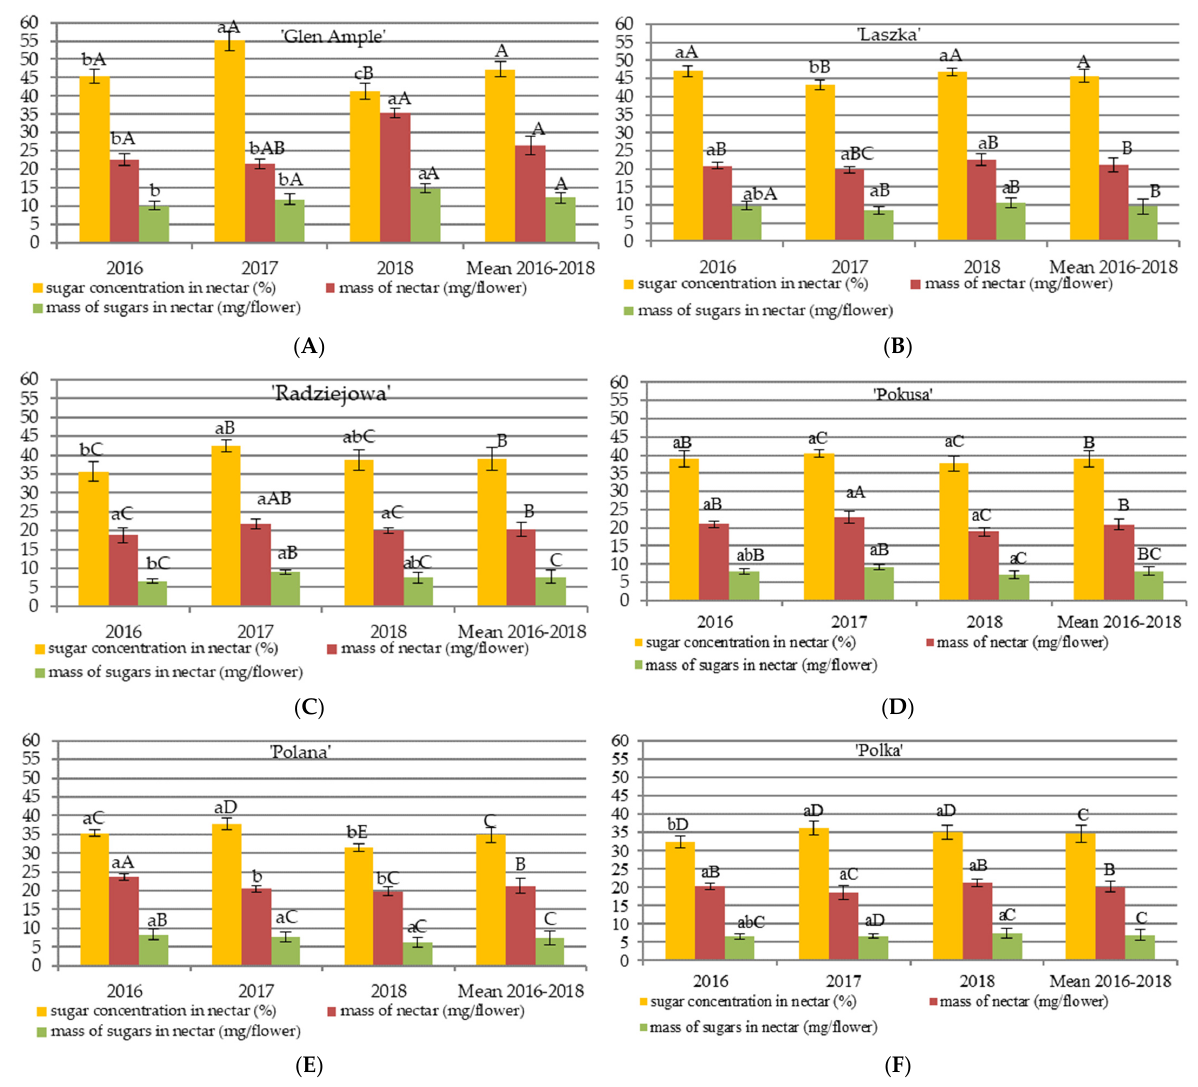
Figure 1. ( A – F ). Nectar abundance: nectar weight, nectar sugar percentage concentration, and nectar sugar weight of the six R. idaeus cultivars analyzed in the three study years. Explanations: means followed by the same small letter are not significantly different within the cultivar in the years, and means followed by the same capital letter do not differ between the cultivars in each year of the study at a significance level α = 0.05 (two-way ANOVA, Tukey’s test). The statistically confirmed differences between the cultivars in the years of the study revealed different trends in the changes in the nectar abundance parameters of the analyzed raspberry cultivars. In terms of the percentage nectar sugar concentration, the taxa were ranked as follows: in 2016—‘Glen Ample’ = ‘Laszka’ > ‘Pokusa’ > ‘Radziejowa’ = ‘Polana’ > ‘Polka’, in 2017—‘Glen Ample’ > ‘Radziejowa’ = ‘Laszka’ > ‘Pokusa’ > ‘Polana’ = ‘Polka’, and in 2018—‘Laszka’ > ‘Glen Ample’ > ‘Radziejowa’ = ‘Pokusa’ > ‘Polka’ > ‘Po- lana’. In 2016, the weight of nectar produced by the flowers of ‘Laszka’, ‘Pokusa’, and ‘Polka’ was significantly lower than in ‘Glen Ample’ and ‘Pokusa’ and lower than in ‘Radziejowa’. The weight of sugar in the nectar from ‘Polana’ and ‘Pokusa’ was